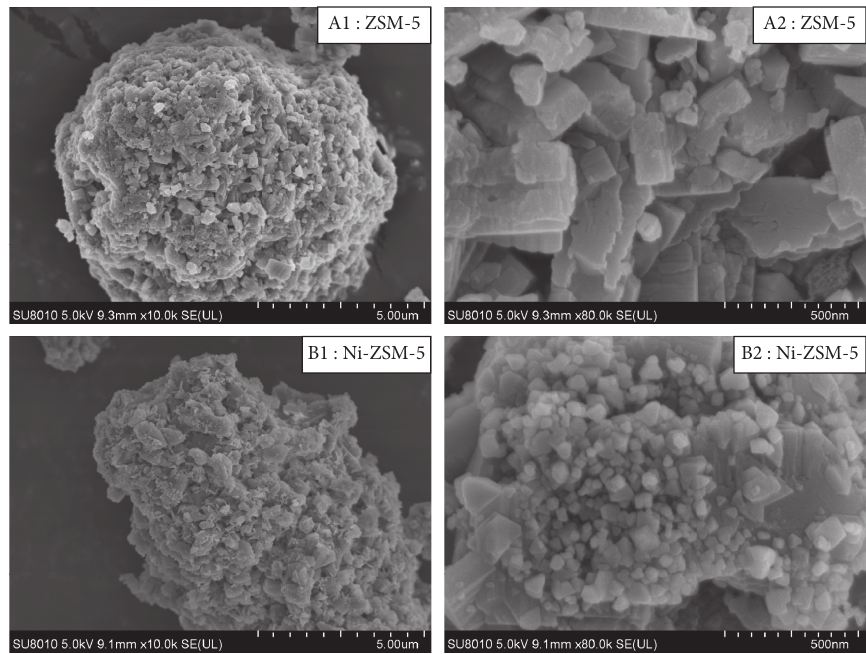
Figure 4: SEM image of ZSM-5 and Ni/ZSM-5